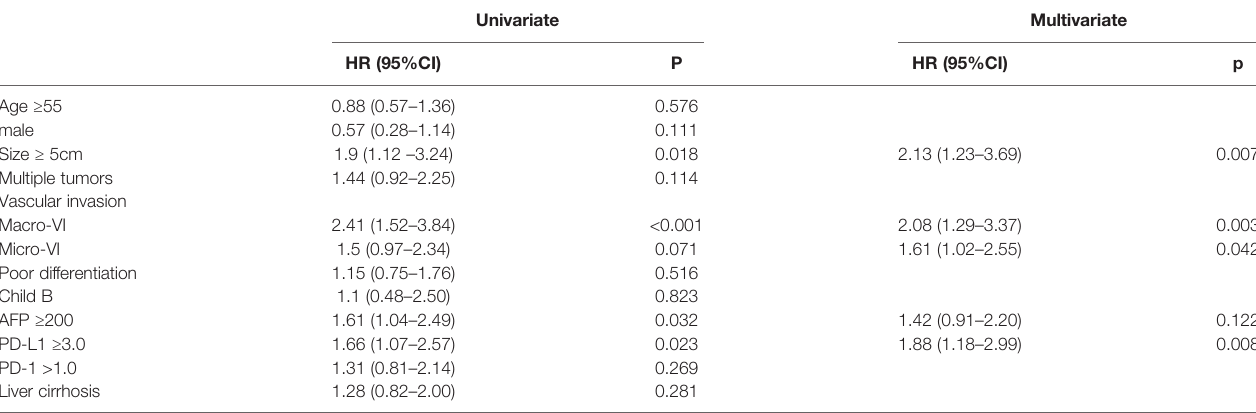
TABLE 3 | Univariate and multivariate analysis of risk factors of tumor recurrence in 122 patients.